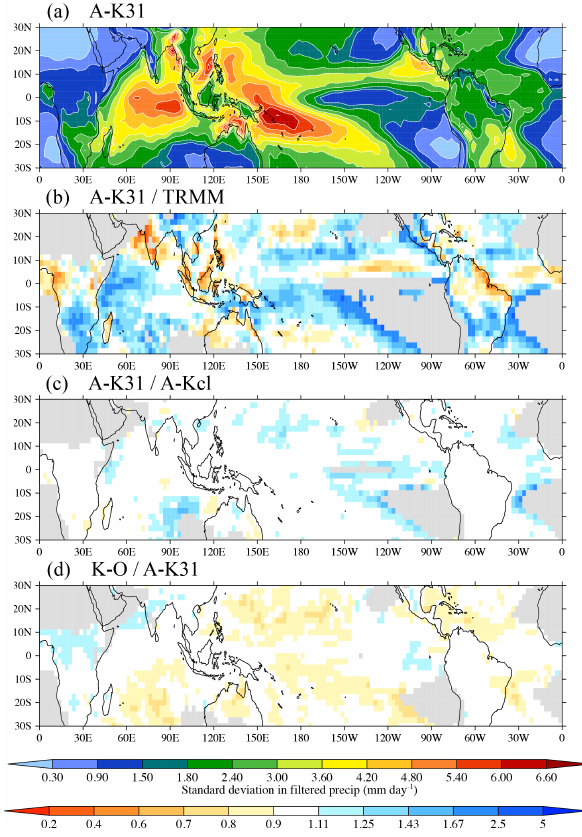
Figure 7. Standard deviation in 20–80-day filtered precipitation from (a) A-K31. Ratio of standard deviations from A-K31 and TRMM (b) , A-K31 and A-Kcl ( c ; impact of SST variability) and K-O and A-K31 ( d ; impact of coupling). In (b – d) , regions with a standard deviation of filtered precipitation below 1mmday − 1 have been excluded from the ratio calculation and masked